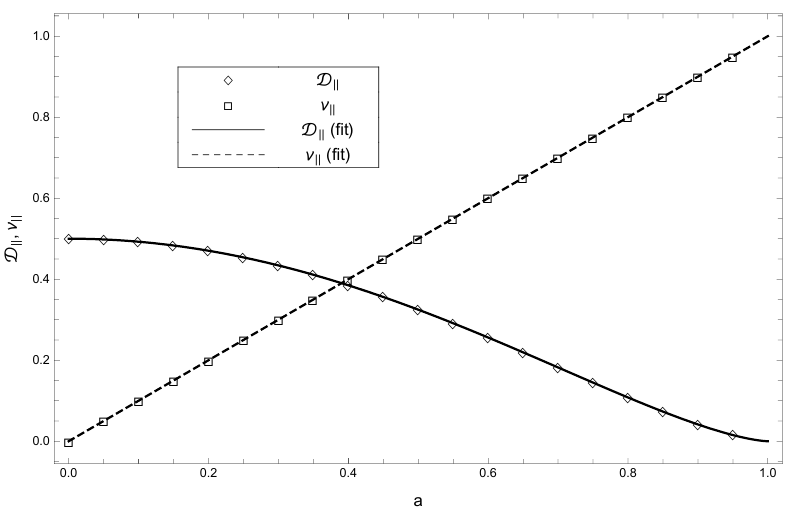
Figure 6 . Momentum di(cid:11)usion and propagation in a simply spinning black hole (case (ii)). The di(cid:11)usion/damping coe(cid:14)cient, D , and propagation speed, v , de(cid:12)ned as expansion coe(cid:14)cients of the hydrodynamic vector mode, (cid:23) (cid:25) v ( a ) j (cid:0) i D ( a ) j 2 . With a (cid:31) 2 (cid:25) 10 (cid:0) 100 , our (cid:12)t suggests v jj jj and D ( a ) = 1 (1 (cid:0) a 2 ) 3 = 2 with (cid:31) 2 (cid:25) 10 (cid:0) 100 . jj ; (cid:12)t 2 viscosity by D = D ( a = 0) = (2 (cid:25)T ) = (cid:17) = ( (cid:15) + P ). Below, in section 4, we will 0 0 0 PSS jj